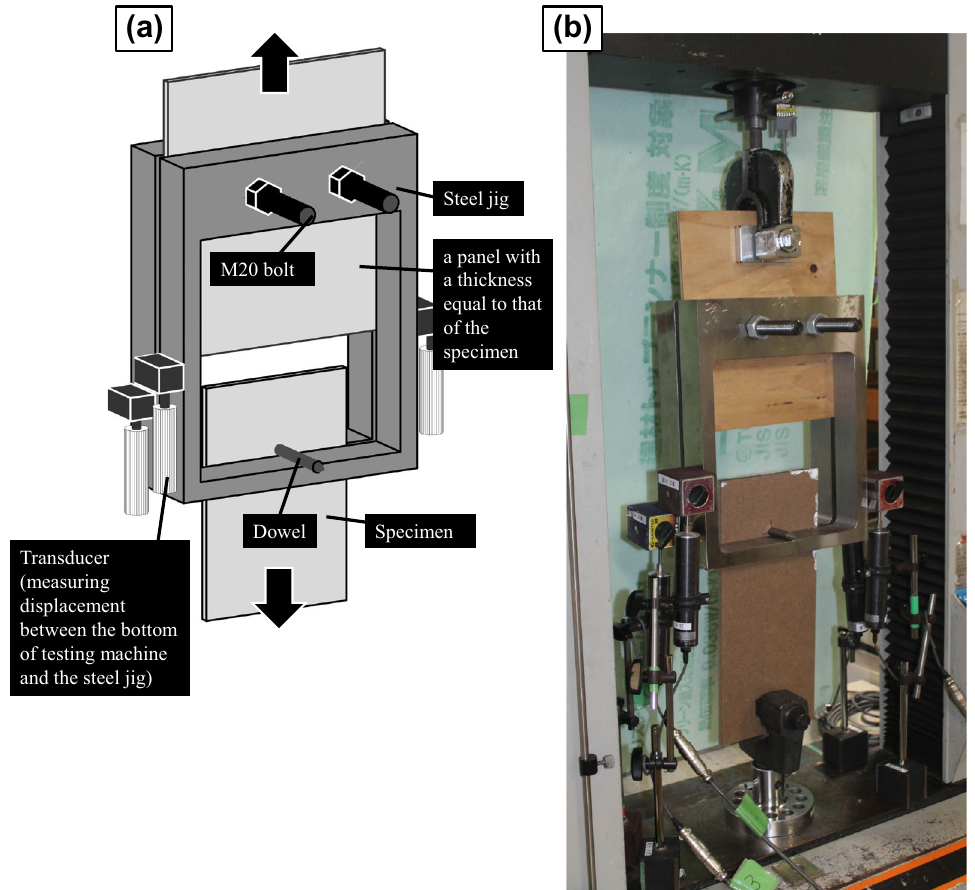
Fig. 3 Schematic illustration of the embedment test. a Schematic illustration of the test setup; b photograph of the test setup (panel d 12 mm, ph 1, and dowel position = =